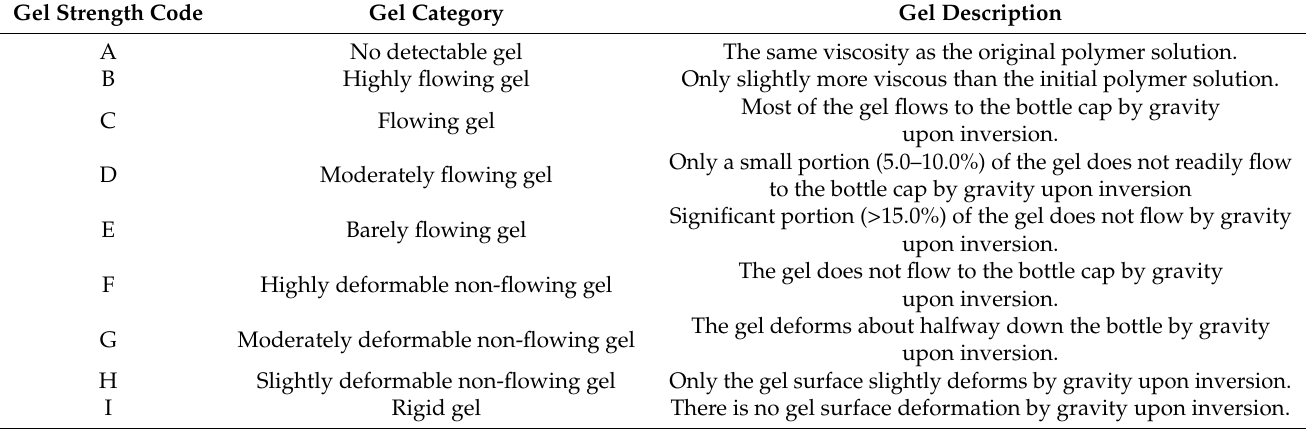
Table 3. Gel strength code